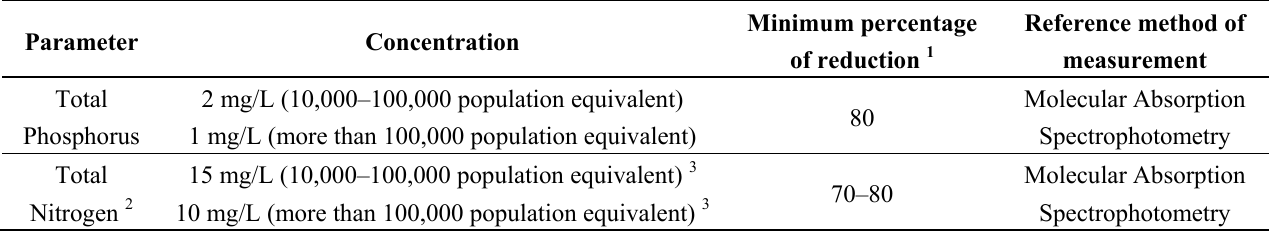
Table 1. European Directive 91/271/EEC Requirements in Matter of Nutrients (from